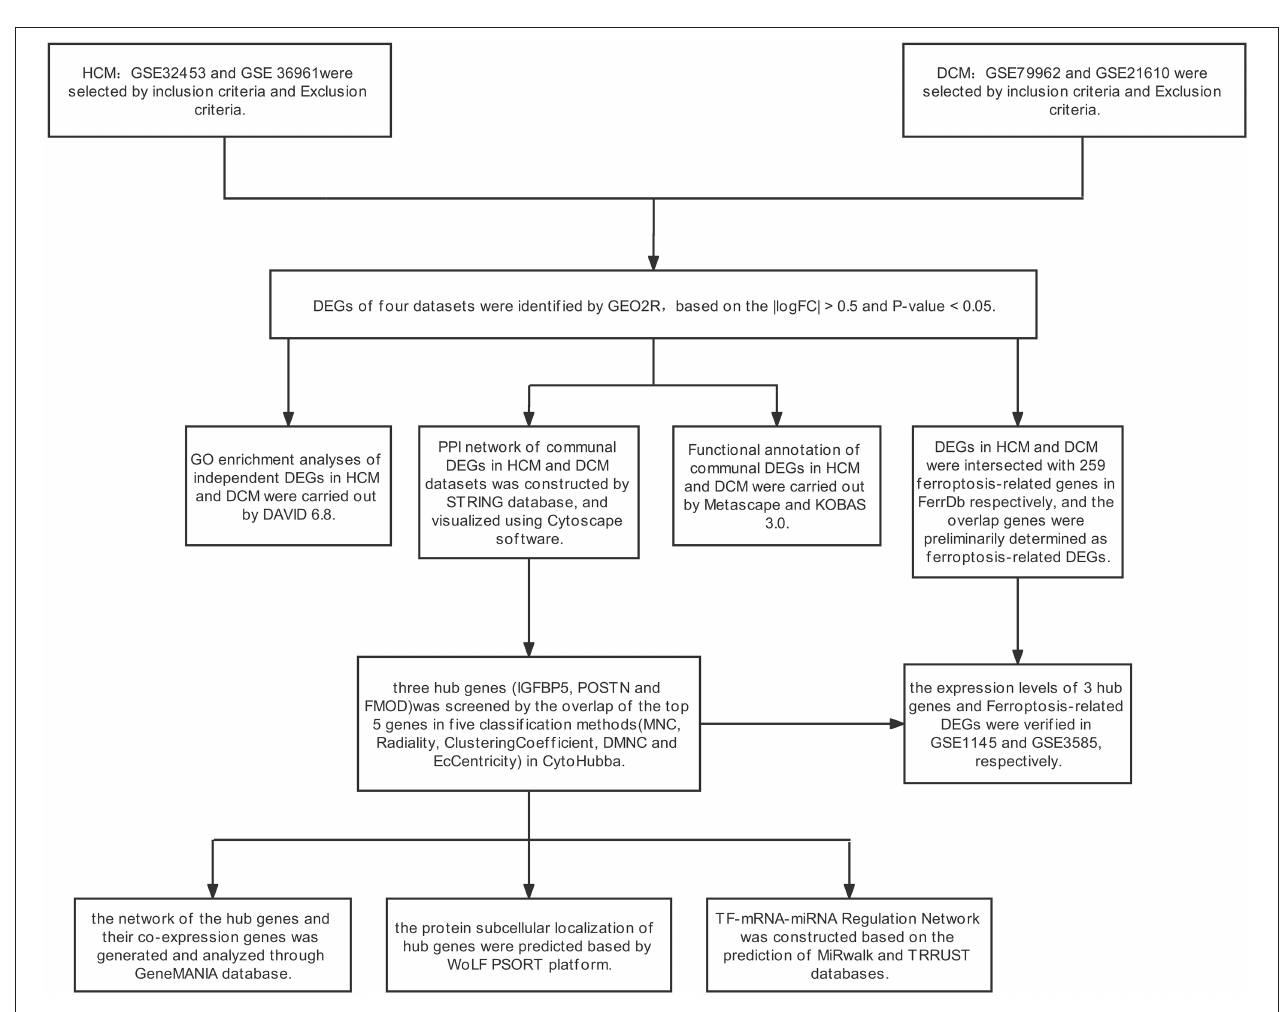
FIGURE 1 | Research design